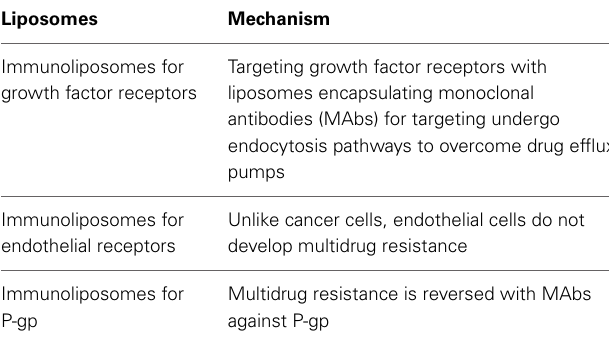
Table 6 | Immunoliposomes and ligands-liposomes to overcome drug resistance.